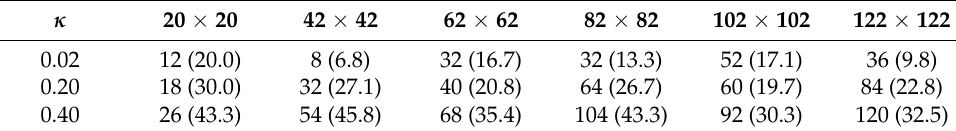
Table 1. Number of u or v slave cells generated and their percentage (in parenthesis) over total u or v cut cells for the flow between concentric cylindrical walls case as function of κ and the grid size.